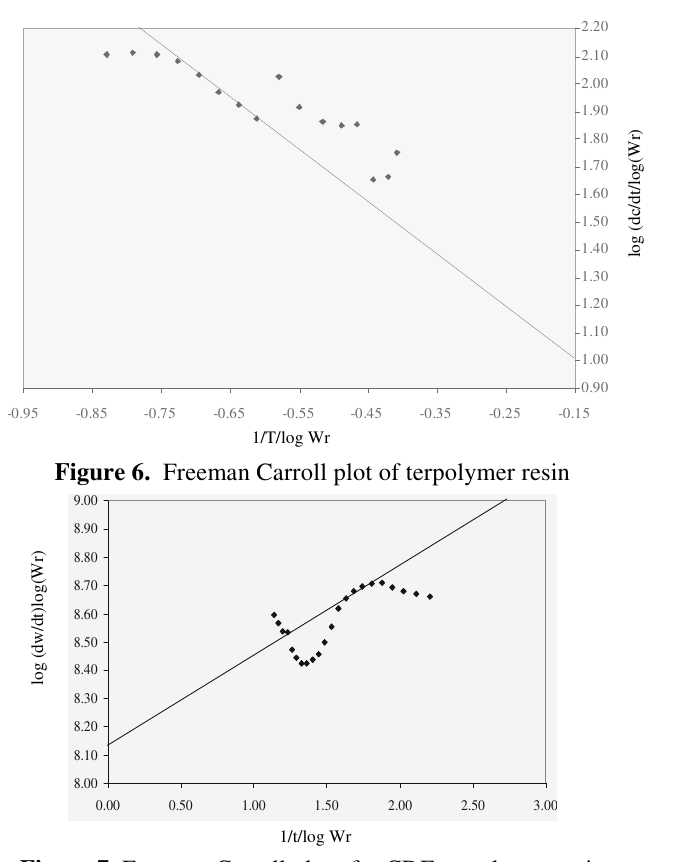
Figure 7. Freeman Carroll plot of p -CDF terpolymer resin